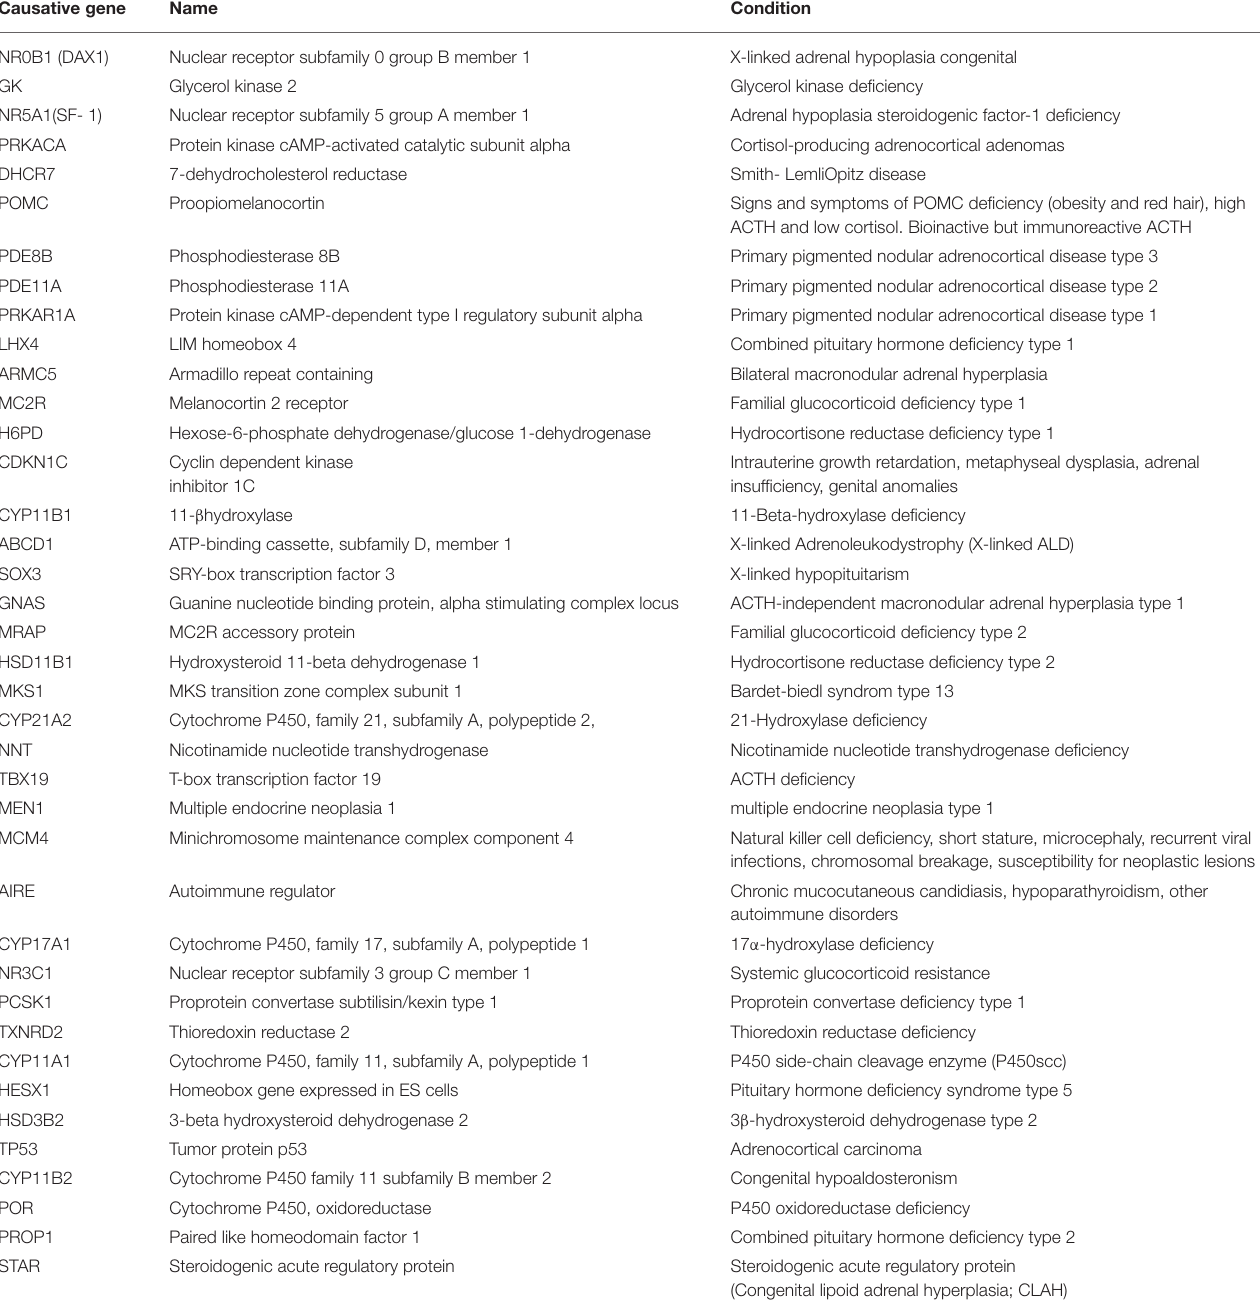
TABLE 1 | Candidate genes were sequenced to identify mutations in patients with adrenocortical insufficiency. Causative